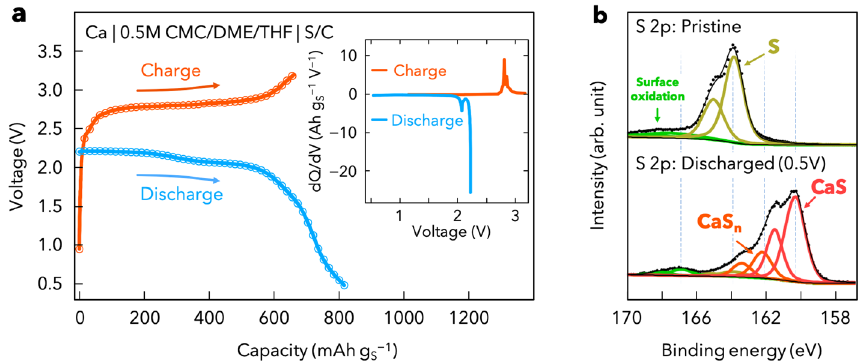
Figure 5. ( a ) Electrochemical performance of the Ca–S batteries with the CMC/DME/THF electrolyte in a voltage window of from 0.5 to 3.2 V; the inset shows differential capacities (dQ/dV), derived from the corresponding charge–discharge curve. ( b ) X-ray photoelectron spectroscopy (XPS) S 2p spectra of the S/C electrodes in the pristine (top) and discharged (bottom)